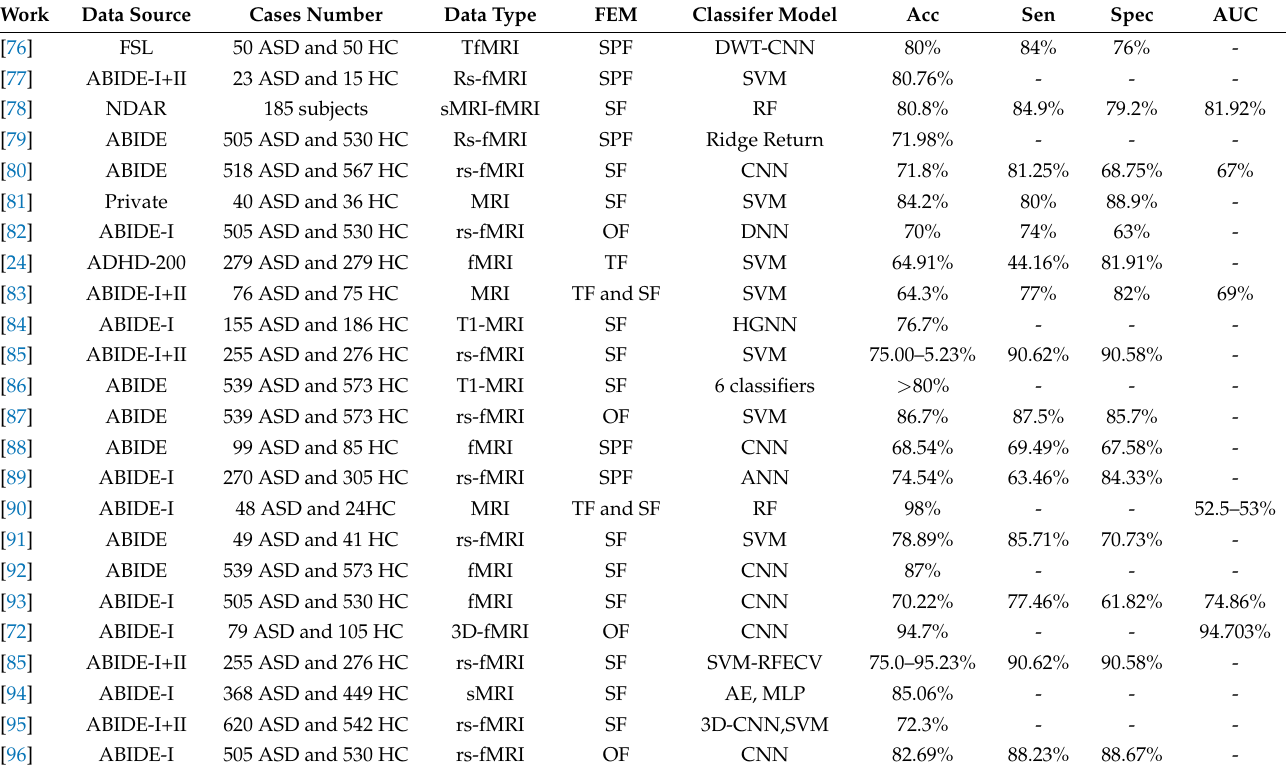
Table 1. Summary of ASD studies using MRI/fMRI with machine learning